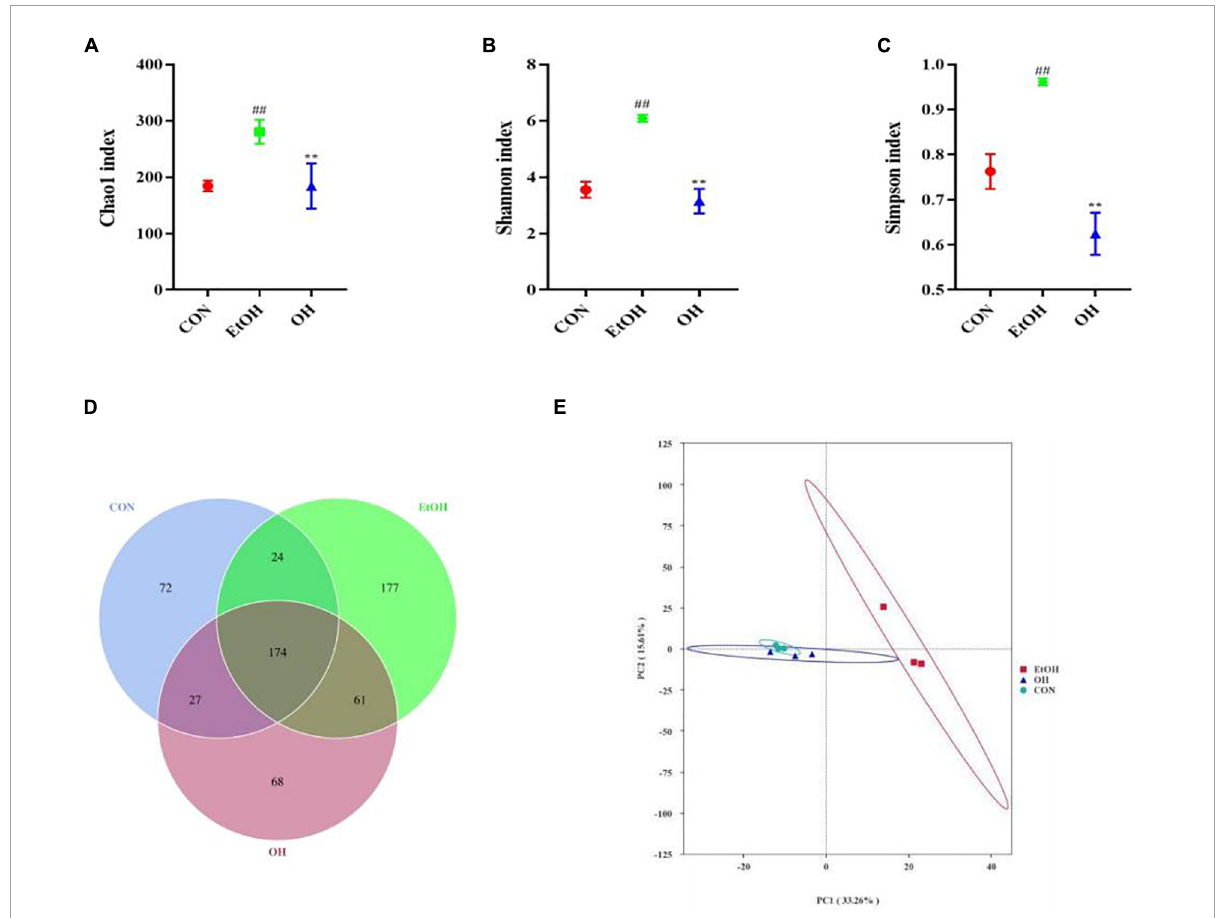
FIGURE6 Effect of OEB treatment on α -diversity and β -diversity in gut microbiota. (A) Chao1 index; (B) Shannon index; (C) Simpson index; (D) Venn diagram of the number of ASVs of all groups; and (E) principal component analysis (PCA) of microbiota. CON, control group; EtOH, ethanol administration group and OH, high-dose OEB group. Data are presented as “mean ± SD”. N = 8, for all groups. ## EtOH versus CON, P < 0.01; ** OH versus EtOH, P <